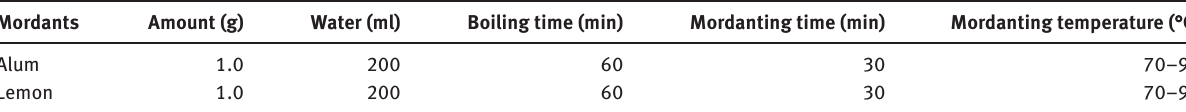
Table 2: Mordanting recipe for textile material. Mordants